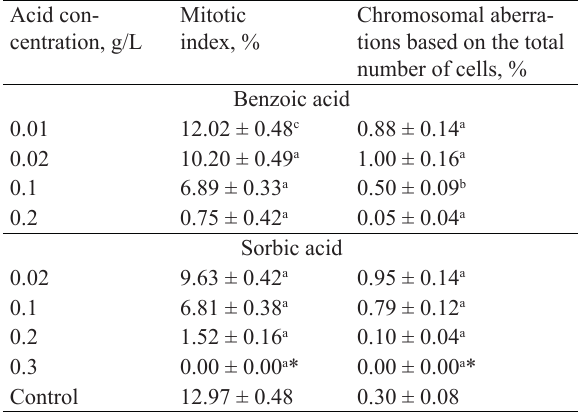
Table 1 Mitotic index and chromosomal aberrations in meristematic cells of onion roots after exposure to benzoic and sorbic acids (n =